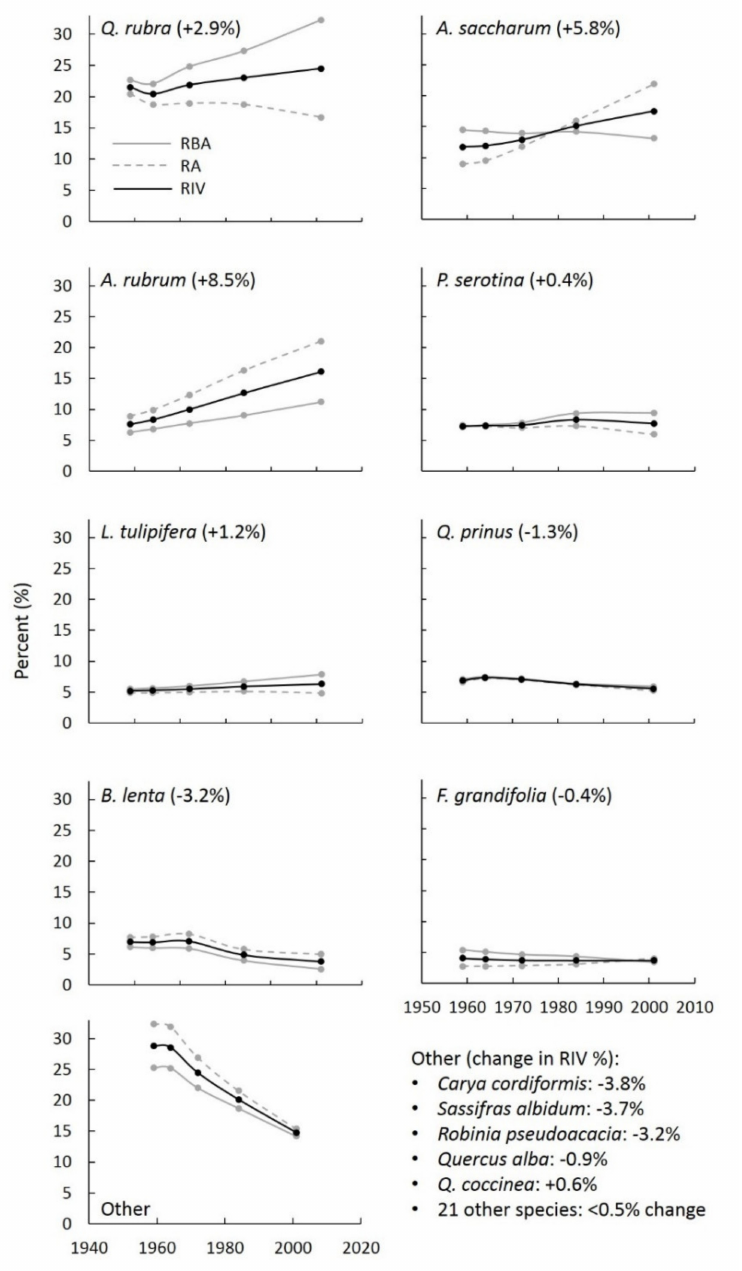
Figure 2. Tree species’ relative importance, abundance, and basal area (%) in FEF WS 4 from 1959 to 2001. The percent changes for species listed under “other” are changes in RIV. Data from the USDA Forest Service Northern Research Station